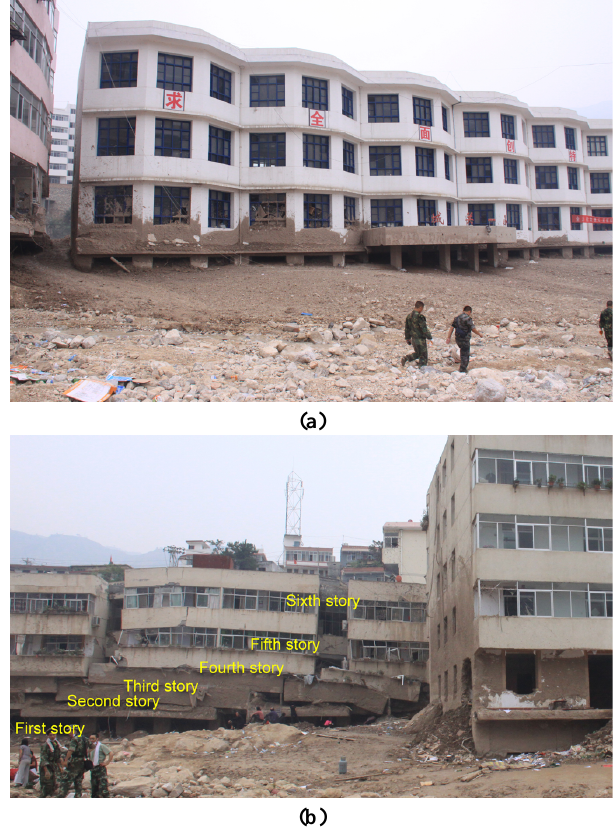
Fig. 6. Back shielding effects. (a) Building C. (b) Building D. Building D was knocked down by the collapse of building E, a case of a failed shielding